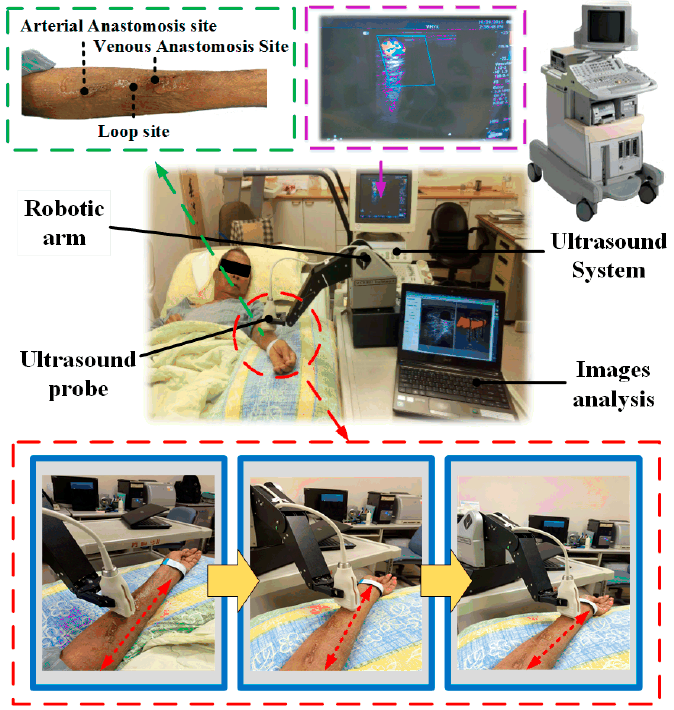
Figure 11. Clinical trials at Kaohsiung Veterans General Hospital (KVGH), Tainan branch, in Taiwan.